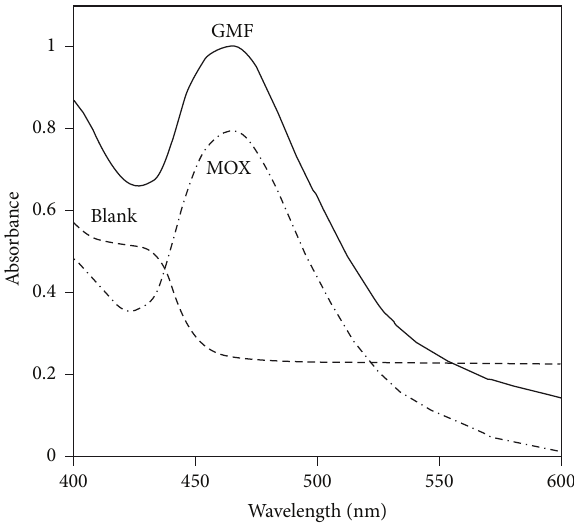
Figure 1: Absorption spectra of 8.0 𝜇 g mL −1 GMF and 10 𝜇 gmL